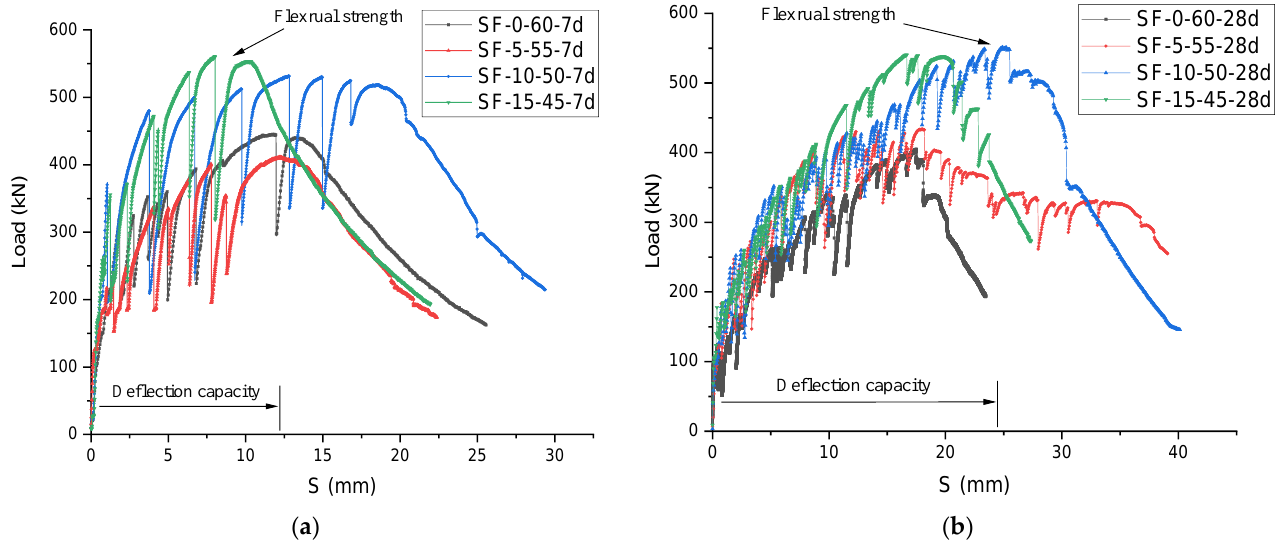
Figure 8. Deflection – flexural strength curves for slag/fly-ash-based ECC mixtures at: ( a ) 7 days ( b ) 28 days.